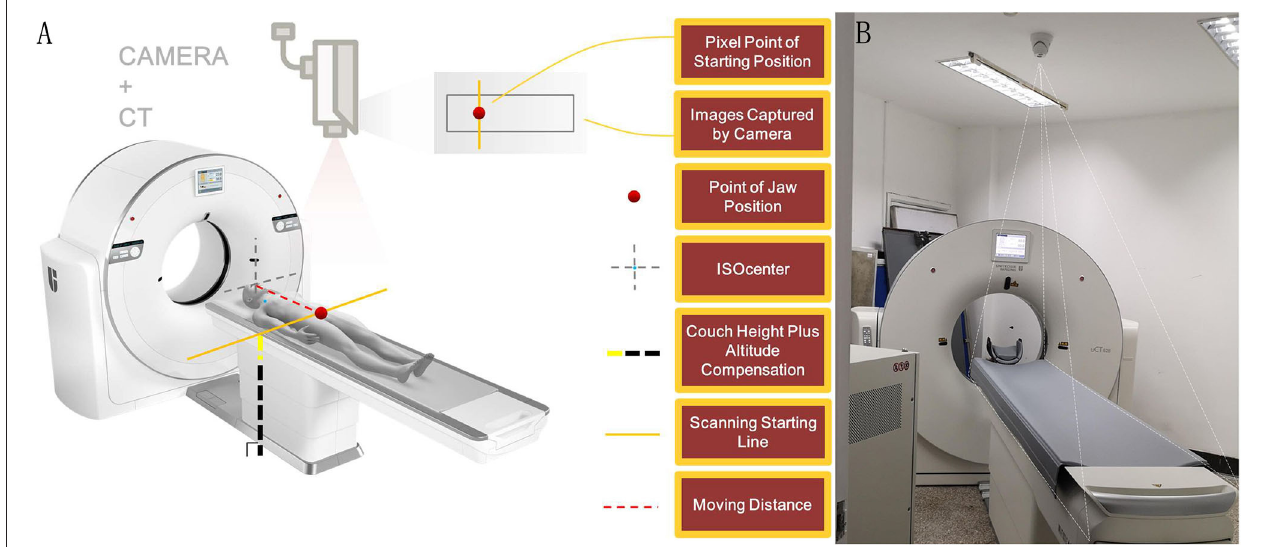
FIGURE 2 | Camera-based intelligent auxiliary positioning system. (A) The working principle of the camera-based intelligent auxiliary positioning system. (B) The relocatable CT system with AI positioning technology in Wuchang Fang Cang Temporary Hospital at Hongshan Stadium in Wuchang district, Wuhan. The figures were provided through the courtesy of Shanghai United Imaging Healthcare Co.,